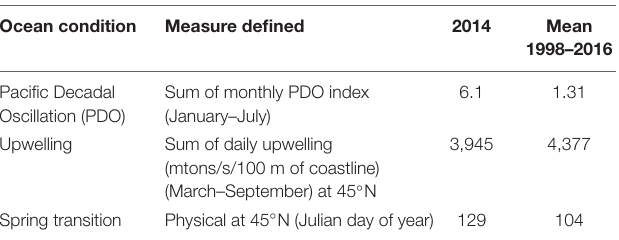
TABLE 1 | California Current Ecosystem ocean conditions in 2014 [Pacific Decadal Oscillation (PDO), upwelling, and spring transition].